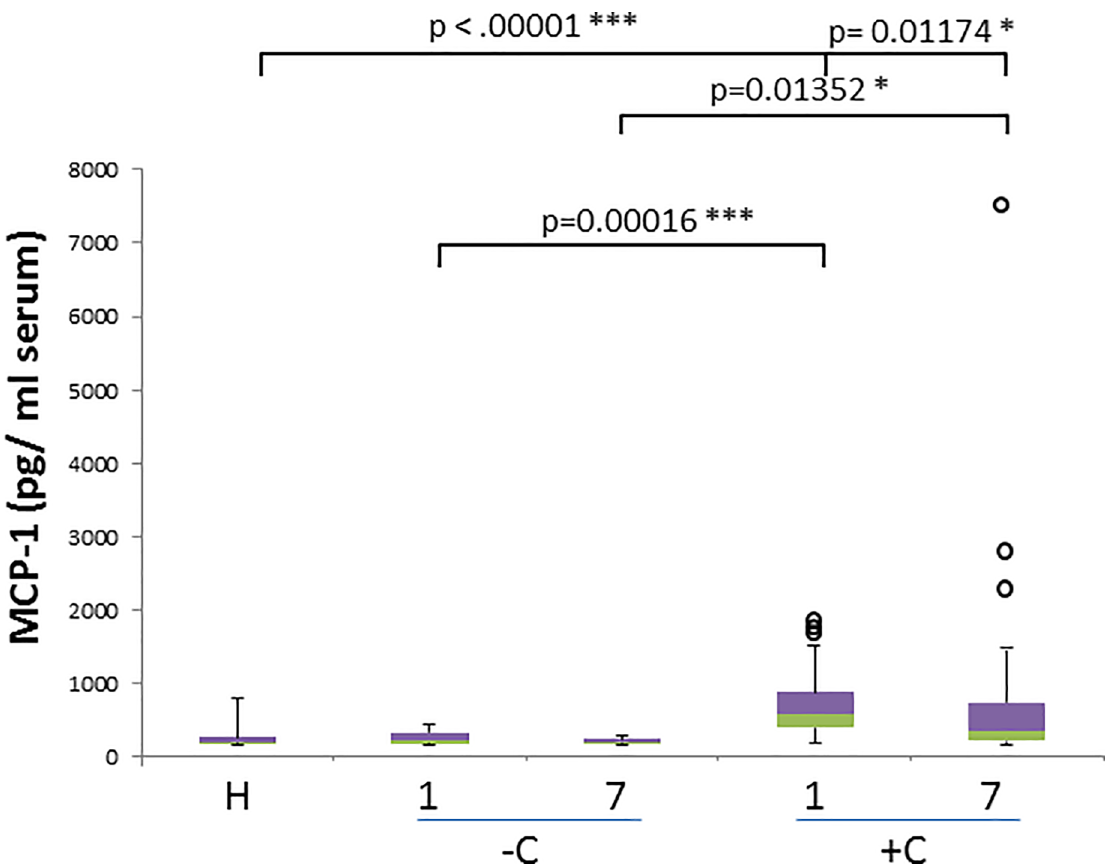
Fig 1. MCP-1 concentration in healthy and naturally infected dogs and its relation with outcome. Box and whisker plot with outliers showinginterquartile range (median bar in intersect betweentwo colors in box) of MCP-1 concentration values amongdifferent groups: healthydogs (H), uncomplicated (-C) and complicated (+C) cases for both day 1 and day 7. Mann- whitney test p- values are shown for comparisonof different